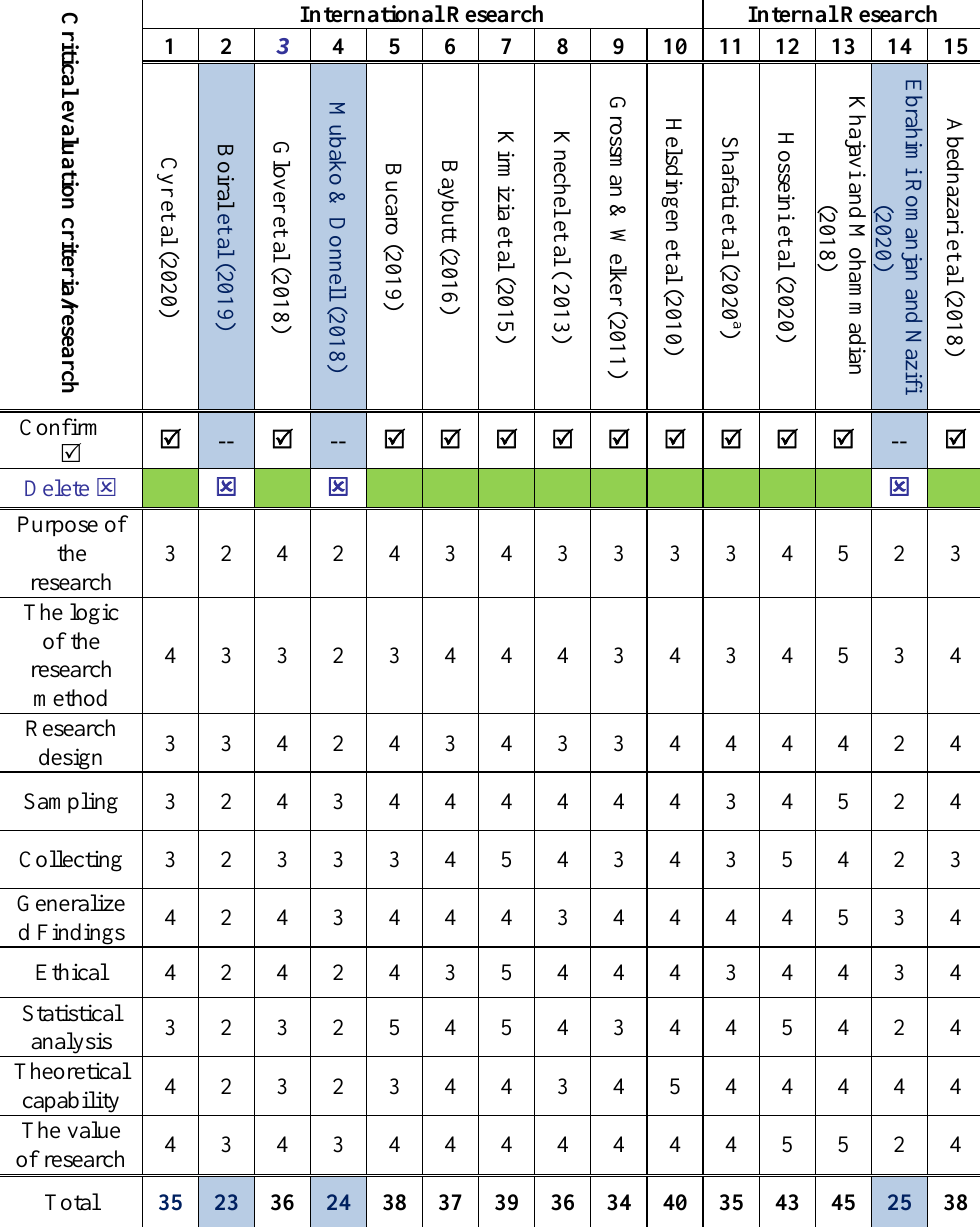
Table 1. Evaluation process of approved research to determine the components